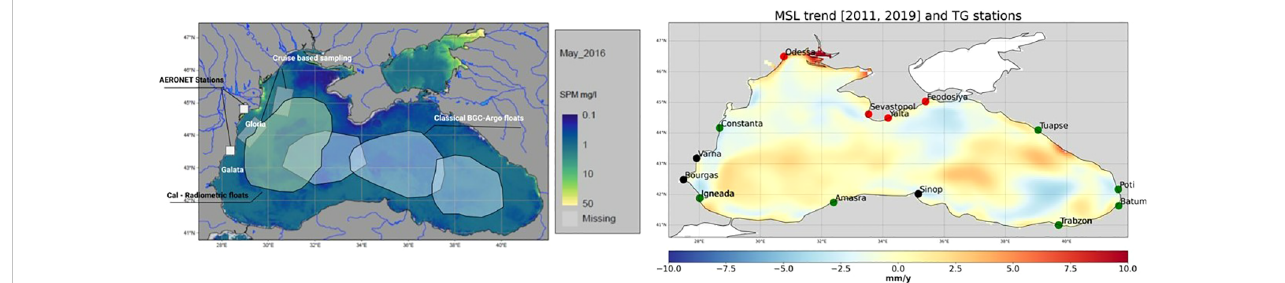
FIGURE 13 Mapping of the approximate positions of the different components of a Black Sea in-situ observing system to support (left) the development of OC products with SPMs superimposed, (right) the validation of altimetry products and estimation of the MSL. For OC, position of current Aeronet OC and suggestion for ship cruises and areas of deployment of BGC Argo are shown. For altimetry, position and names of tide gauge (TG) are indicated with different colour corresponding to the length of the dataset and its extension over recent years. In green, TG datasets are available to validate the MSL trend derived from altimetry (selection criteria: duration of the dataset > 10 years with datasets delivered recently i.e. >2015). In red, Russian TG datasets extend at least over 1992-2005. In black, TG datasets that cannot be used for the validation of the MSL trend (i.e., less than 10 years in common with the altimetry era).